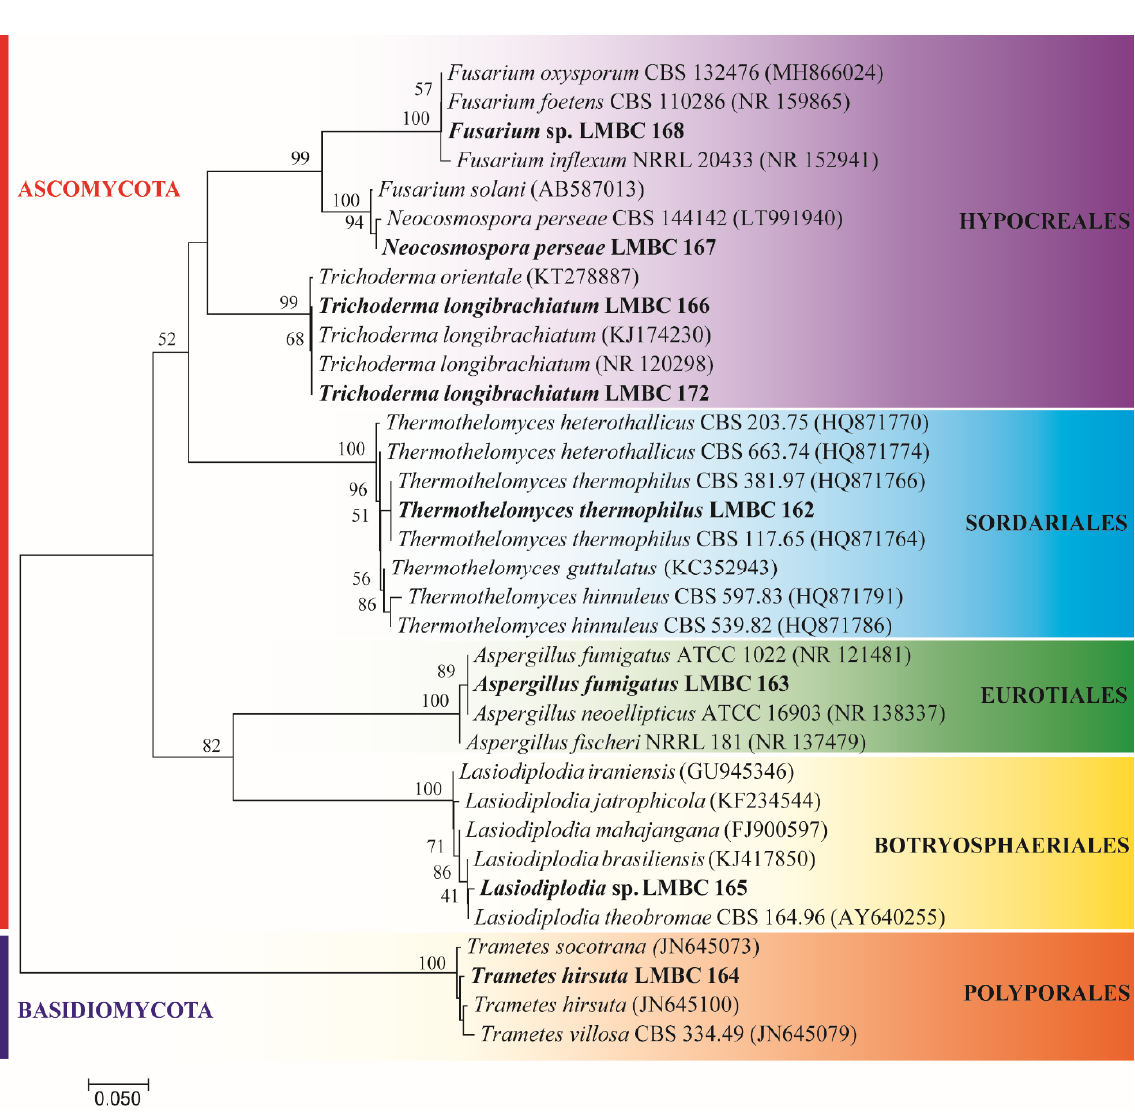
Figure 1. Phylogenetic relationship among the filamentous fungi isolated from tree trunks (bold) and the closest related species.